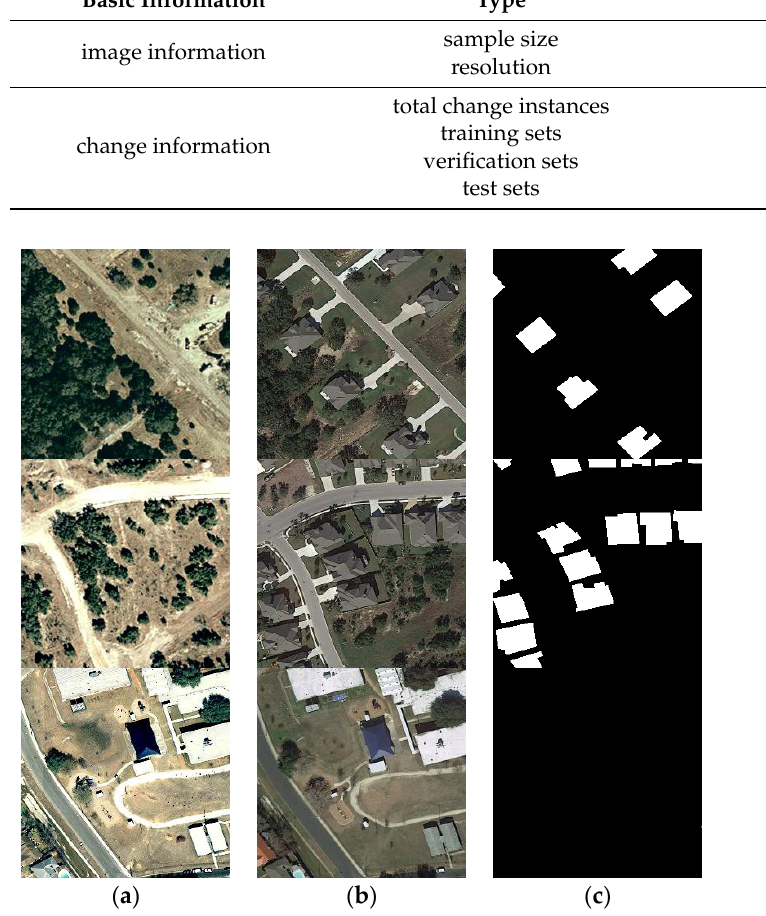
Figure 7. Two-phase images and change information of the LEVIR-CD building dataset. ( a ) image1; ( b ) image2; ( c ) label.